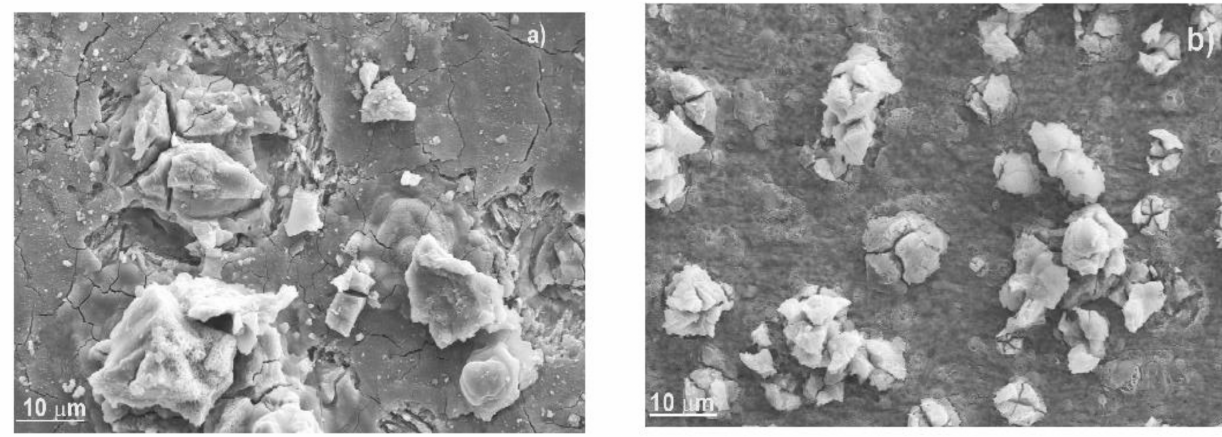
Figure 9. SEM micrographs of X-120 steel corroded in a CO 2 -saturated NaCl solution at 50 ◦ C containing ( a ) 0 and ( b ) 100 ppm of gemini